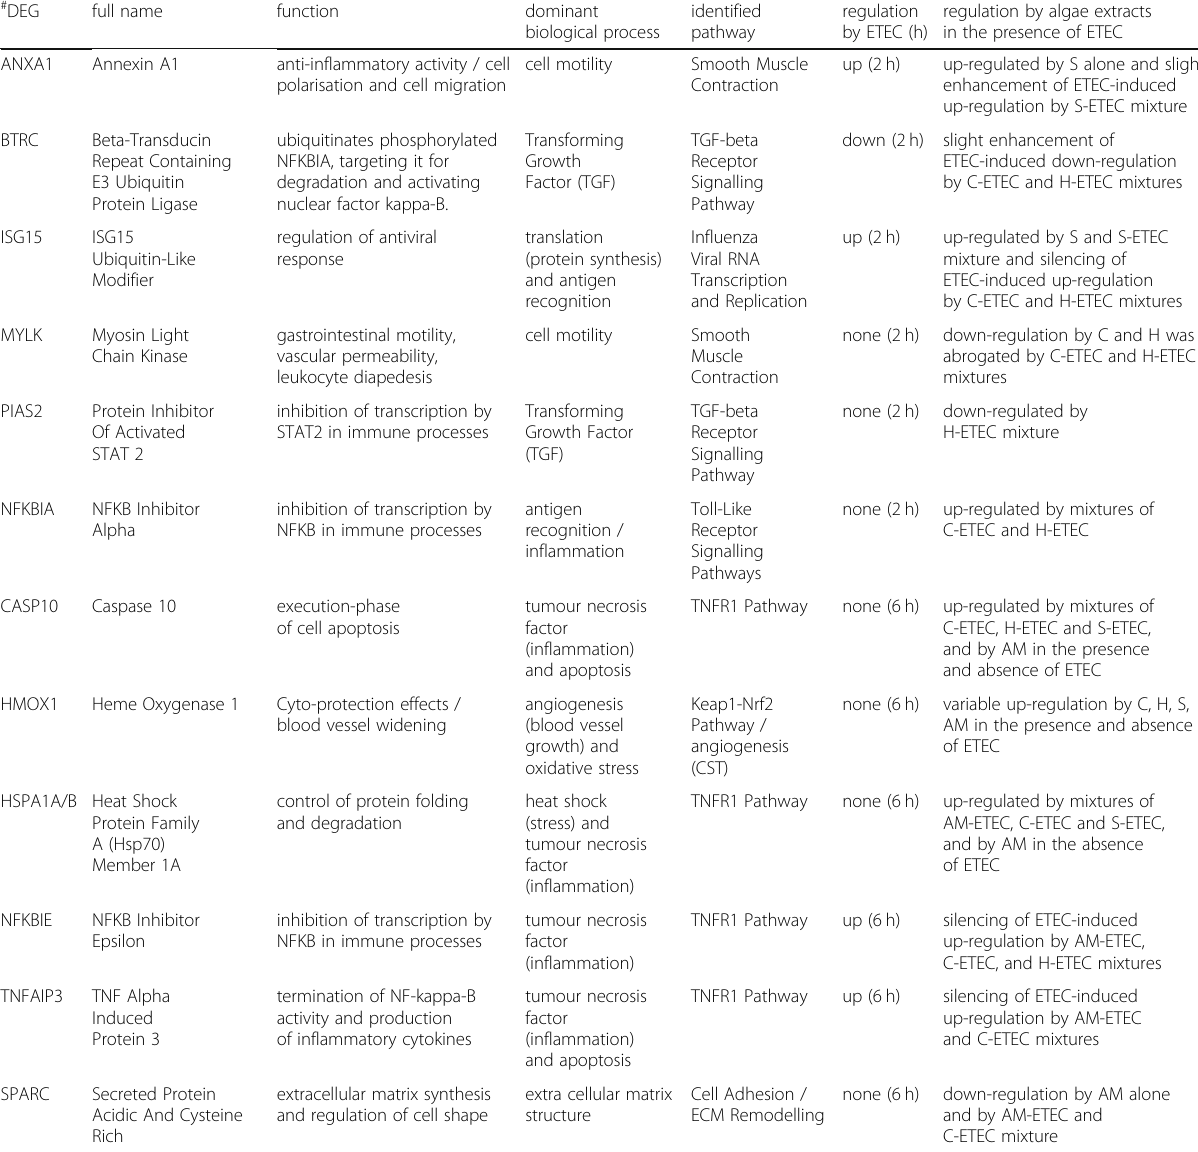
Table 5 DEGs with an important regulatory function in biological processes induced by algae